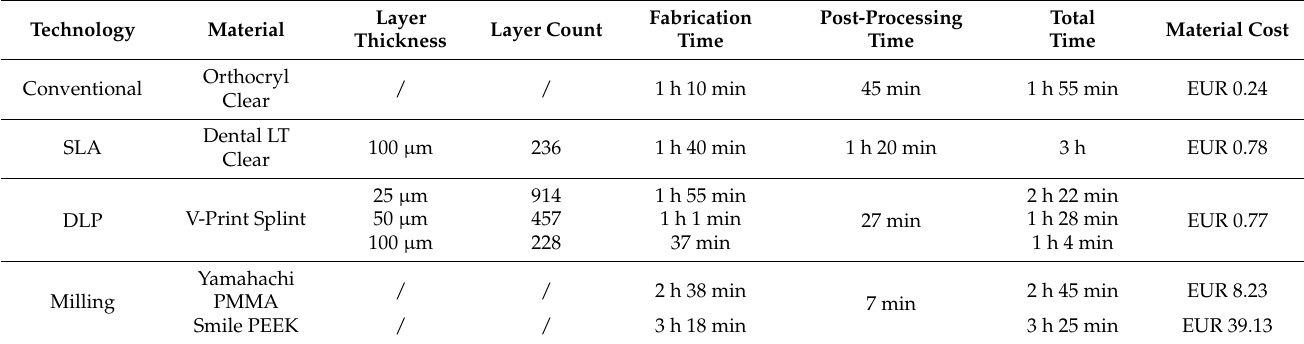
Table 3. Manufacturing time for producing four palatal plates at once for the different technologies and materials: conventional, stereolithography (SLA), direct light processing (DLP) and milling. Information on layer thickness and layer count are also provided for additive manufacturing (AM) technologies. Cost per part is shown for each